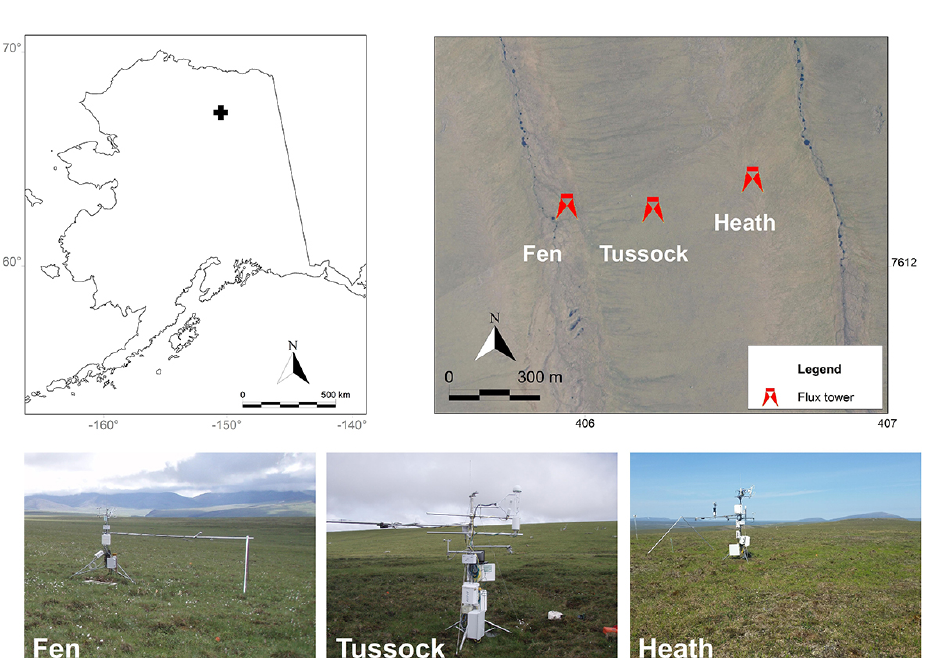
Figure 1. Location of the Fen, Tussock and Heath flux towers at the Imnavait watershed. Right panel map is in UTM-6N NAD83 with coordinates in